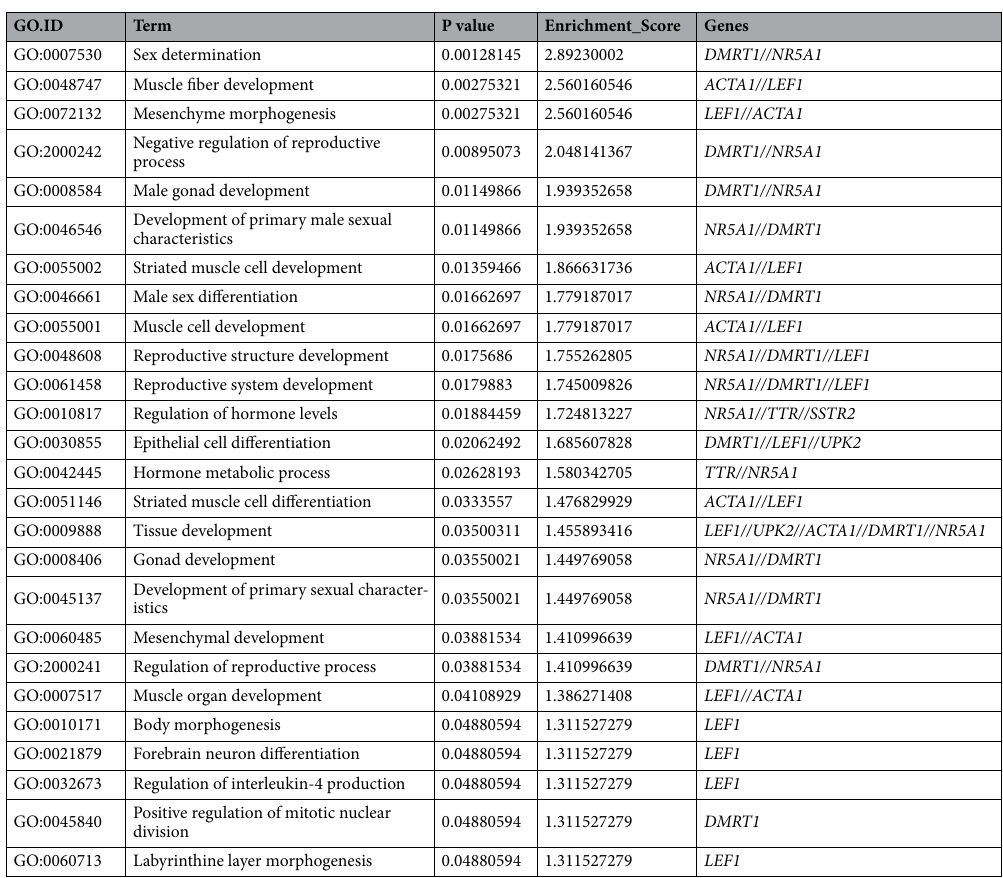
Table 4. The biological processes with down-regulated gene enrichment scores.